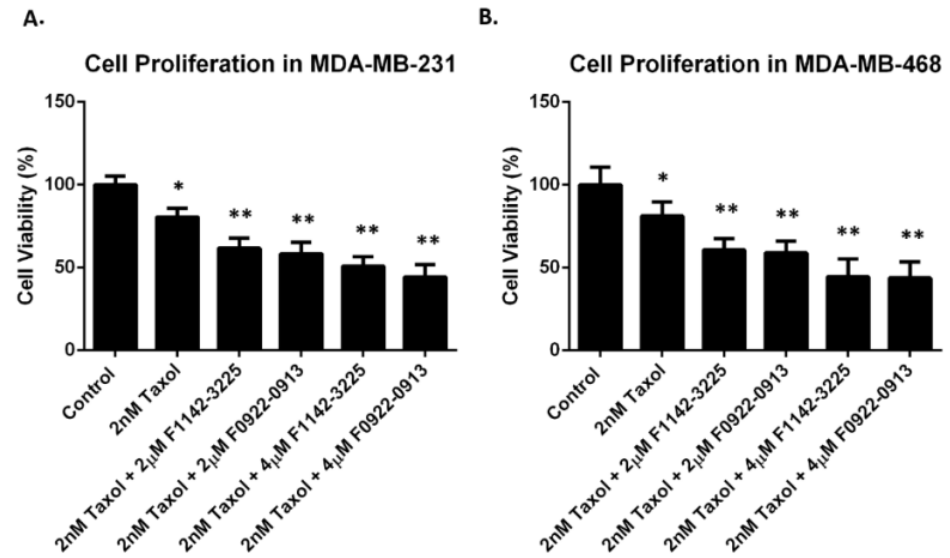
Figure 4. Cell proliferation in response to the combined treatment of taxol and inhibitors in TNBC cell lines. Cell proliferation determined by cell proliferation reagent WST-1 in MDA-MB-231 ( A ) and MDA-MB-468 ( B ) cells treated with taxol, in the presence or absence of F2114-3225 or F0922-0913, for 4 days. Data are reported as % of DNA synthesis vs. control (100%). Each point represents the mean of four replications (mean ± SD). Statistical significance was determined by one-way ANOVA; * p ˂ 0.05 vs. control (ctrl); ** p ˂ 0.01 vs. control (ctrl). Furthermore, the effect of inhibitors with taxol treatment was also determined in MCF10A cells. It was shown that there was no significant change in proliferation in re- sponse to the combination treatment of F1142-3225 or F0922-0913 with taxol (approxi- mately 77.9% vs. 80.0%) (Figure 5). Thus, it was demonstrated that the combined admin- istration of F1142-3225 or F0922-0913 could significantly increase the cells’ sensitivity to taxol in the TNBC cell lines, but not in MCF10A cells.